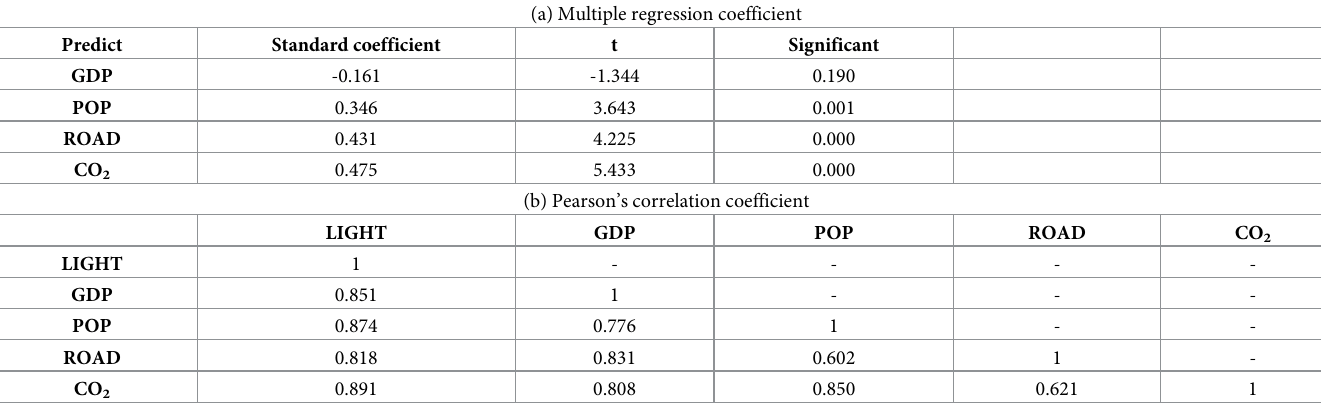
Table 6. Multiple regression coefficient table and Pearson correlation coefficient table of total NTL amount in Indian state. (a) Multiple regression coefficient